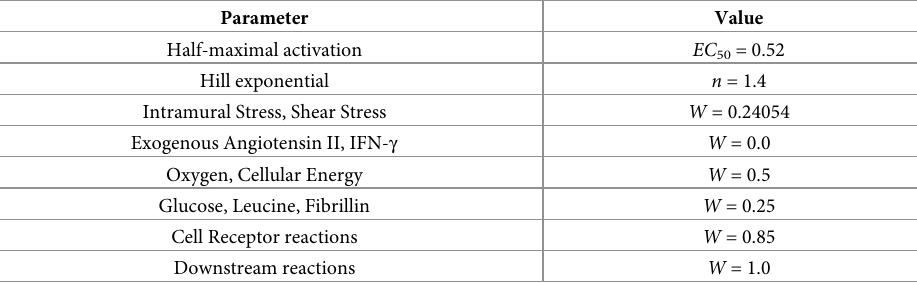
(i.e., setting y = 0 for TSC1/2 in the network; Table 2) results in a hyperactivation of max mTORC1 signaling, leading to upregulation and downregulation of multiple intracellular Table 1. Network model